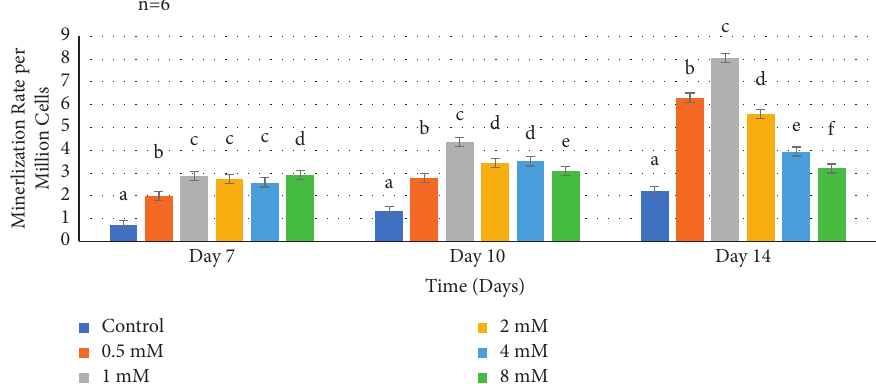
Figure 5: Mineralization rate of human dental pulp cells in media with supplemental Mg 2+ concentrations. Normal human dental pulp cells were cultured with media containing supplemental Mg 2+ concentrations 0.5 mM, 1mM, 2mM, 4 mM, and 8mM and 0mM as the control group for time periods of 7, 10, and 14 days. Mineralization of fixed cell samples was measured by spectroscopic analysis at 405nm and normalized per million cells at each time interval. The control cells were treated with growth media without supplemental Mg 2+ . The data are presented as means of six replicates with error bars indicating the standard deviation. Groups labeled with different letters differ statistically as compared to the control group and other study groups ( P < 0 . 0001).